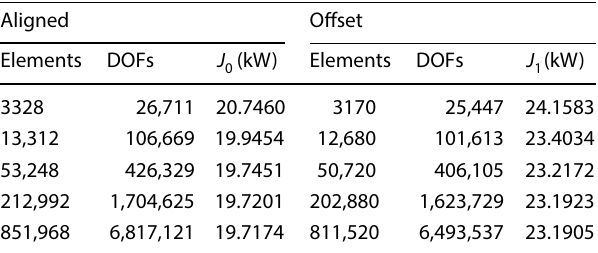
Fig. 1 a , b Initial meshes for the aligned and offset cases with turbine footprint regions indicated by blue squares. c , d